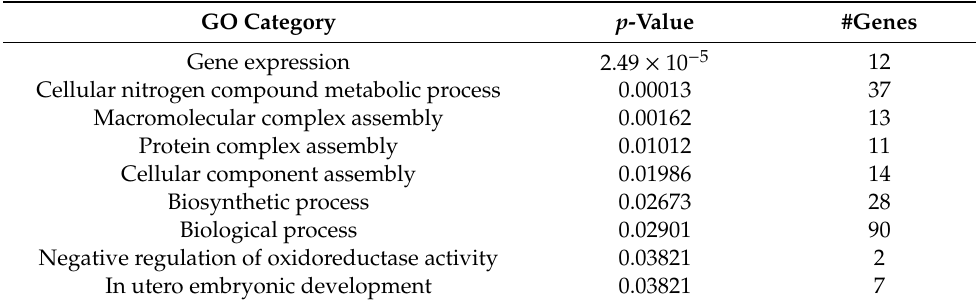
Biological processes, in which potential targets of miR-4792 are involved, which were predicted by